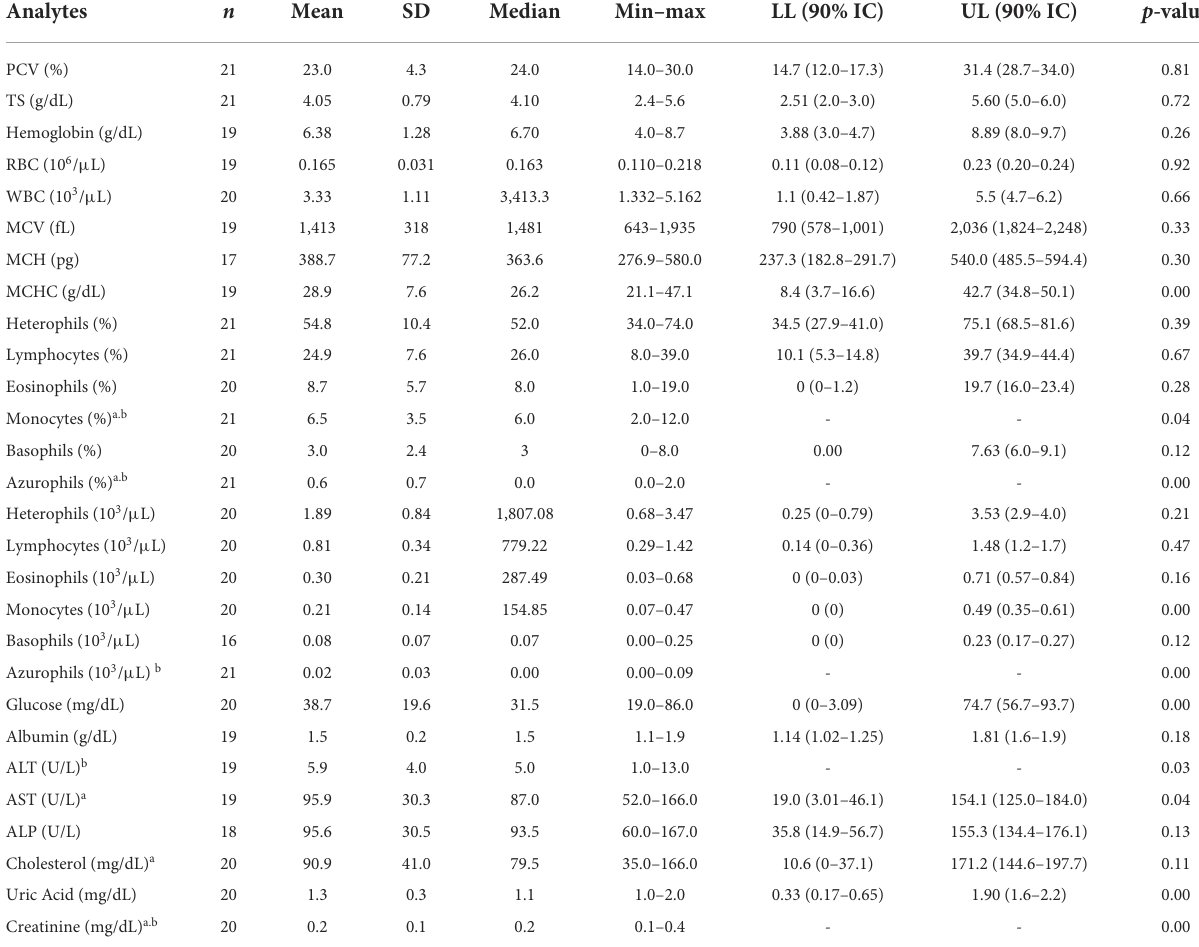
TABLE 3 Hematological and blood chemical values of the Yellow-spotted river turtle ( P. unifilis